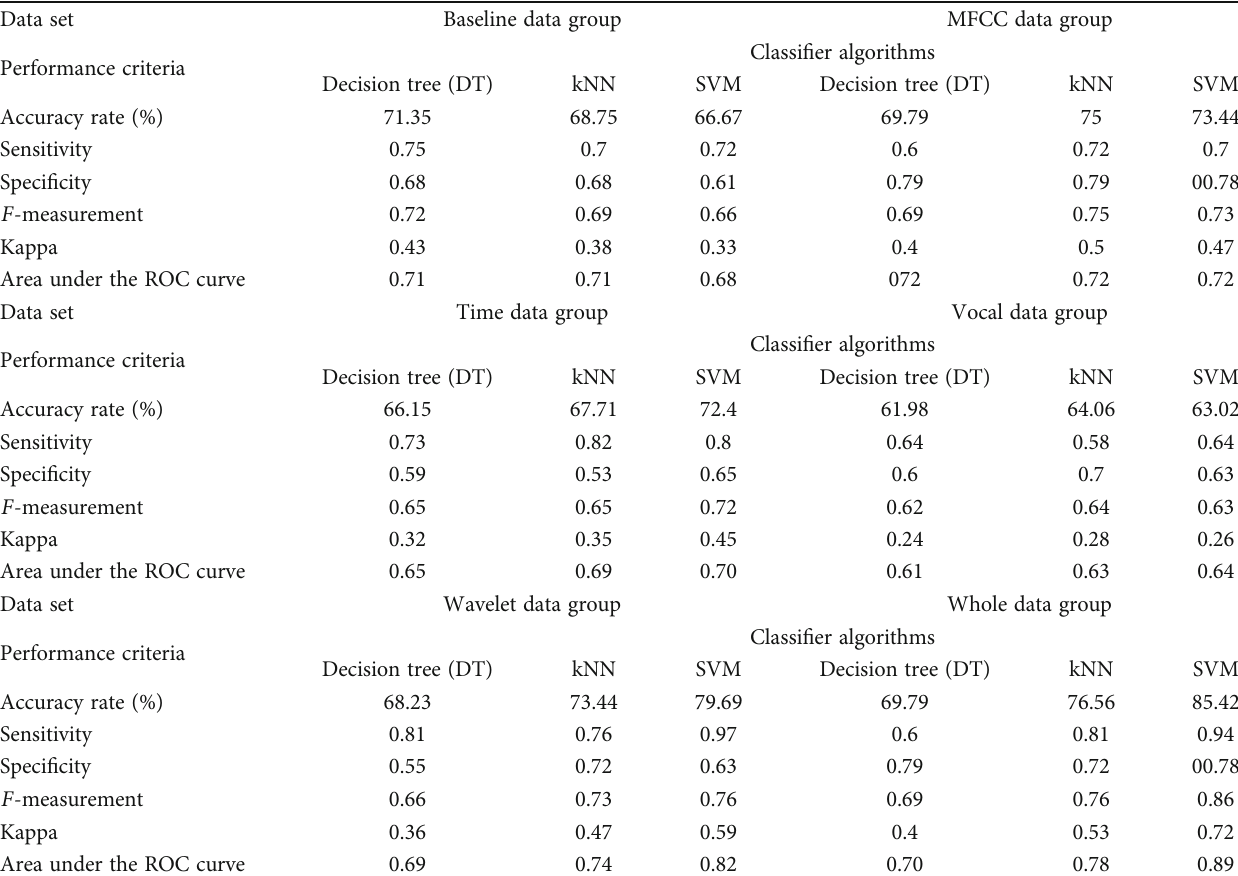
Table 2: Classi fi er achievement data for each data